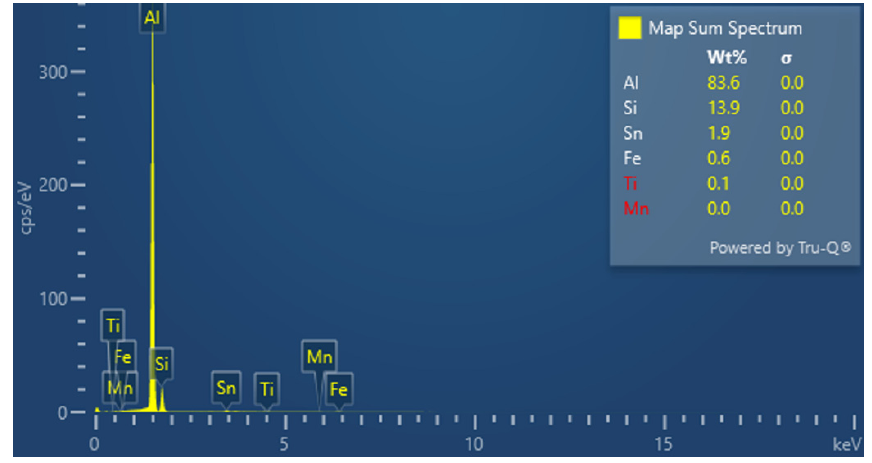
Figure 16. SEM-EDS layered image—AlSi10Sn1.7 alloy.